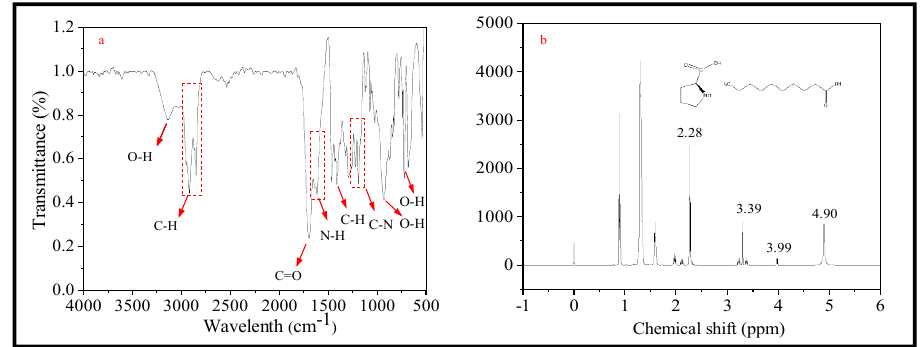
Figure 4. ( a ) FT-IR of NADES (decanoic acid: L-Pro:4.2:1); ( b ) 1 H NMR spectra of NADES (decanoic